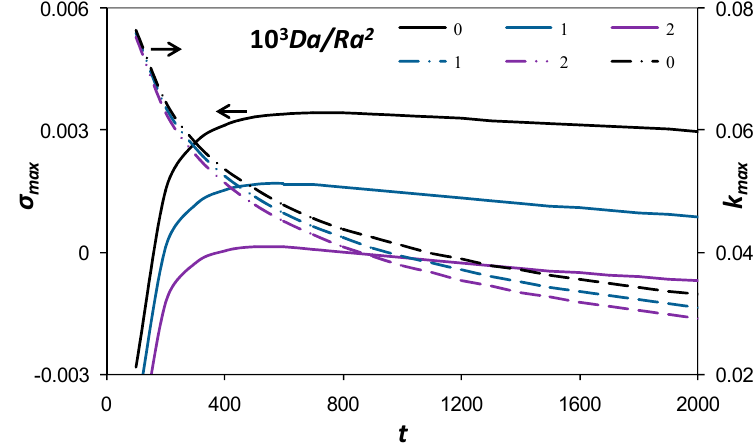
Figure 5. The maximum growth rate of perturbations ( σ 1 pmax ) and the corresponding most unstable wave number ( k max ) as a function of time, for three different Da / Ra 2 , using the dominant mode analysis.